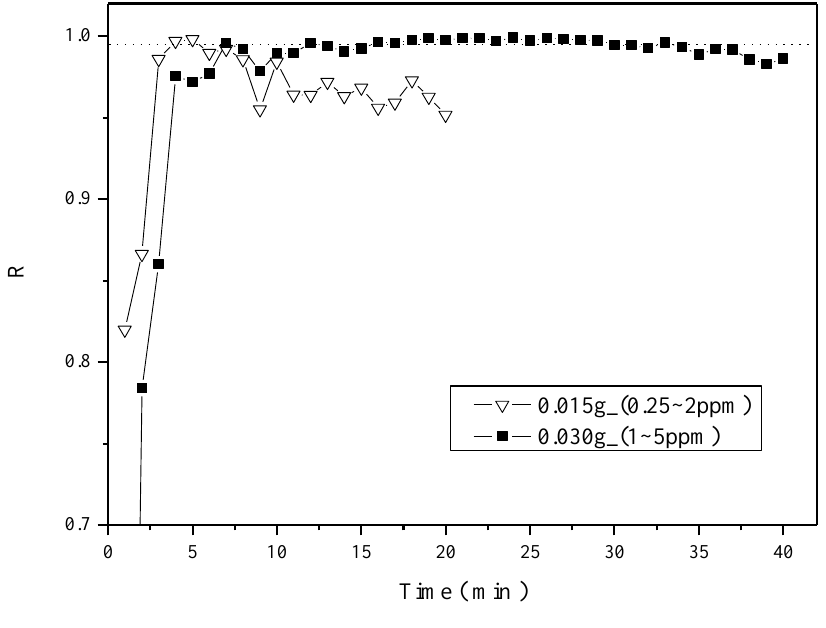
Figure 9. Comparison of the correlation coefficient (R) as a function of NH using different amounts of Al-MCM-41(50)/BG